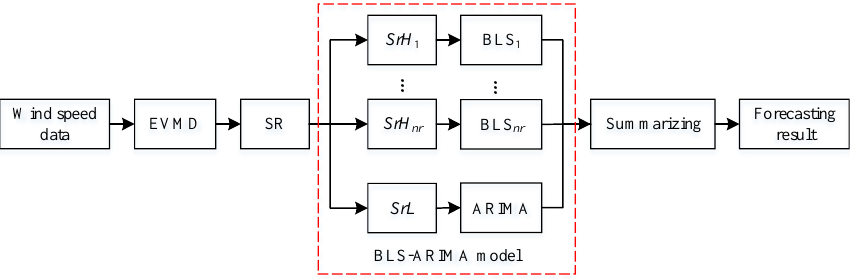
Figure 5. The framework of the EVMD-SR-BLS-ARIMA hybrid wind speed forecasting model.